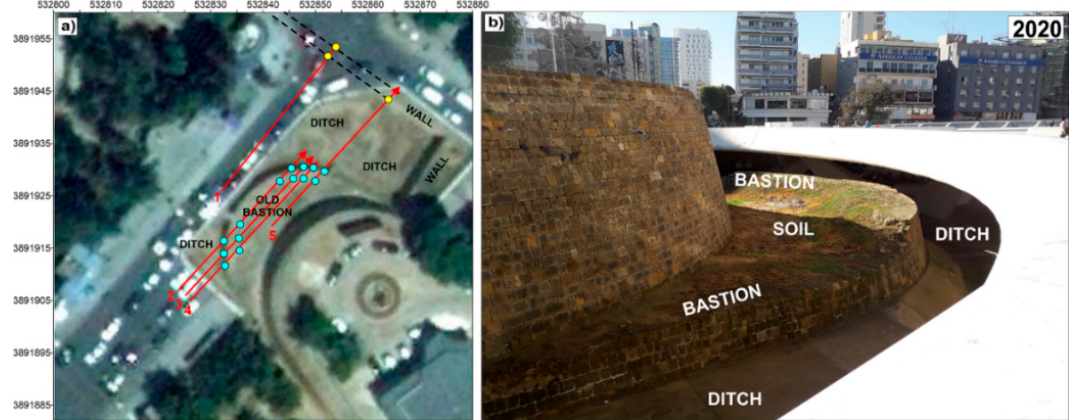
Figure 7. Eleftheria Square: Location of ERT profiles 1–5 and geophysical anomalies on a Google Earth™ satellite images (2011) after archaeological excavations at Eleftheria Square ( a ) and a picture of the excavated ancient bastion inserted in the new square ( b ). the excavated ancient bastion inserted in the new square ( b